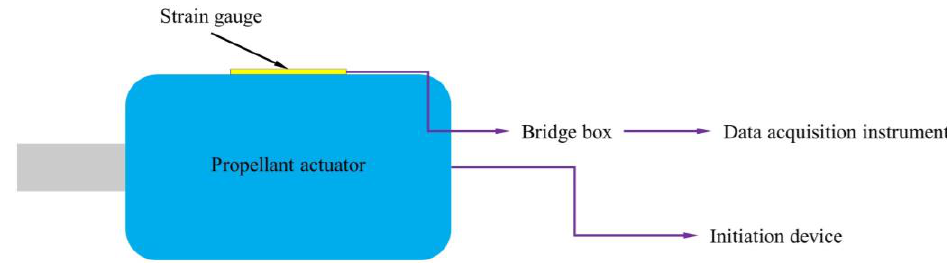
Figure 2. Schematic of electrical measuring